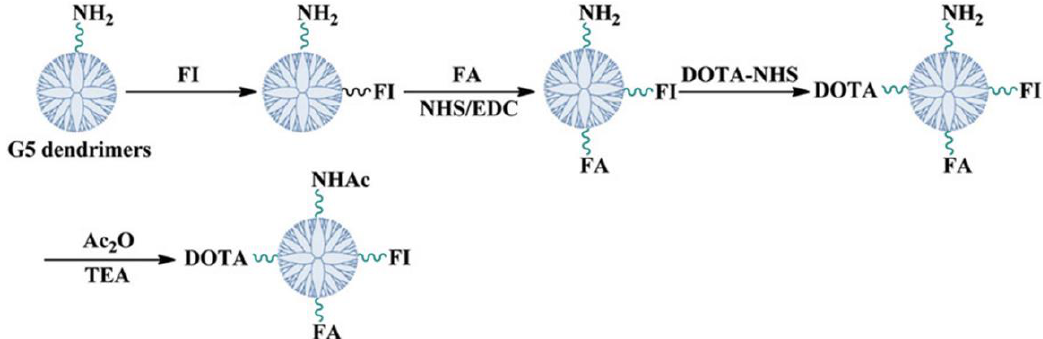
Figure 6. schematic illustration of DOTA-FA-FI-G5·NHAc dendrimers synthesis [44]. Figure 6. Schematic illustration of DOTA-FA-FI-G5 · NHAc dendrimers synthesis